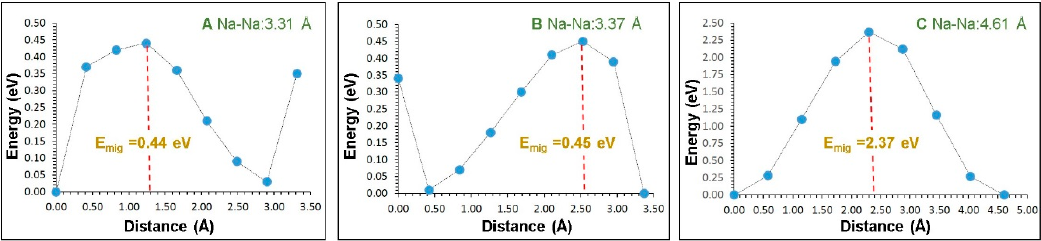
Figure 4. Three different energy profile diagrams for Na local hops, as shown in Figure 3. ( A – C ) correspond to the local Na–Na hops. Table 2. Na-Na separations and their activation energies for the Na ion migration, as shown in Figure 3. Migration Path